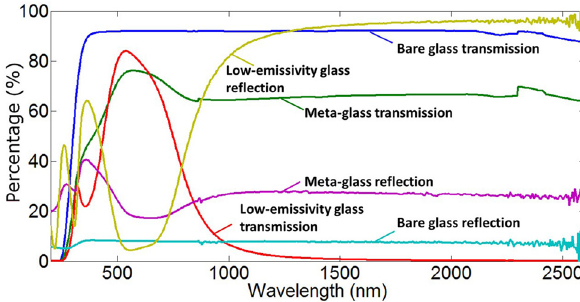
Figure 9: Measured spectral optical transmission and reflection for the bare glass substrate, meta-glass, and low-emissivity glass under normal